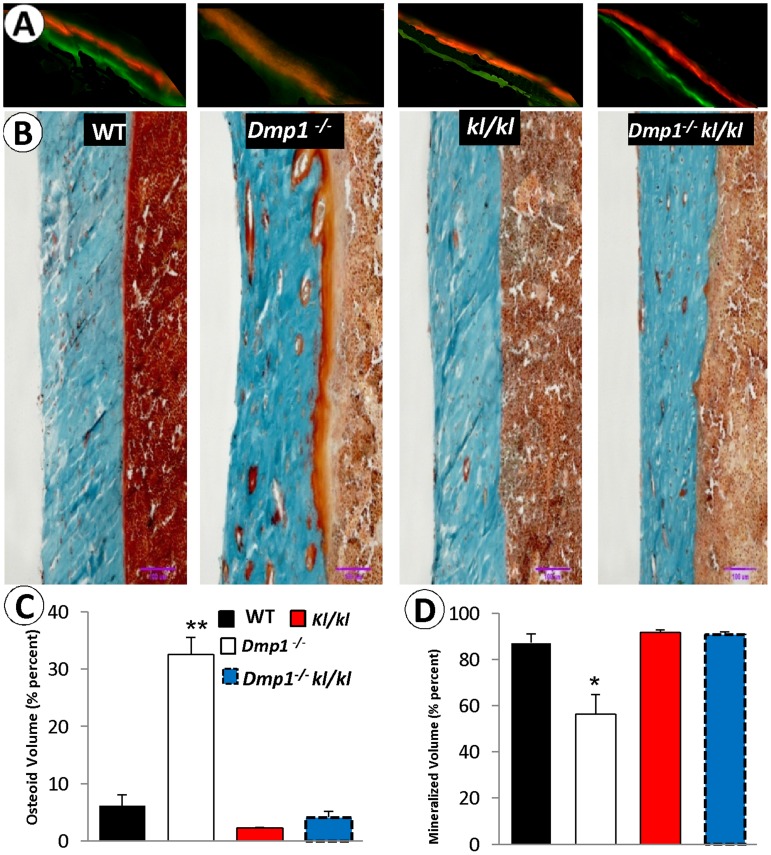
Ablation of Klotho rescued bone formation rate and osteomalacia phenotype in the compound deficient (Dmp1−/− kl/kl) mice.(A) Confocal microscope images of flurochrome labeling of 6 weeks old mice tibias (red: alizarin red, green: calcein). Note that in the Dmp1−/kl/kl mice the bone formation labeling pattern is similar to that of the control and the kl/kl mice. (B) Goldner’s stain showed the massive osteoid (red) areas commonly seen in the Dmp1−/− long bone, which was restored to normal in the Dmp1−/−kl/kl mice. (C, D), Quantitative bone histomorphometric analyses showed that the above changes of the osteoid area (C) and the mineralized area (blue in color) (D) were statistically significant. *P<0.05; **P<0.01 compared to the WT; (n = 3 in each group).